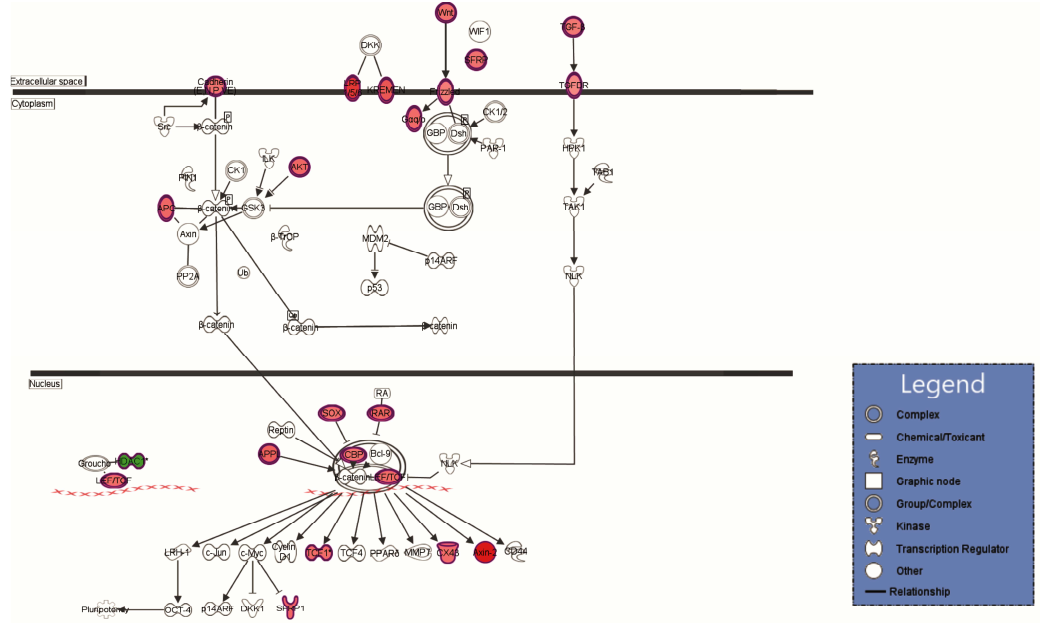
Figure 3. The predicted molecular connections between the differentially regulated genes in the extracellular space, cytoplasm, and nucleus of IPEC-1 cells under the LB mixture action. Information about the regulation of genes is included in the figure: the red color gradient from dark to light shows the degree of genes up-regulated in lactobacilli treated IPEC cells versus control cells. Nodes were used to connect the regulated genes; grey lines show inconsistent or no predicted effects; ( ) = direct relationship; ( ) = inhibition; n = 4. ) =